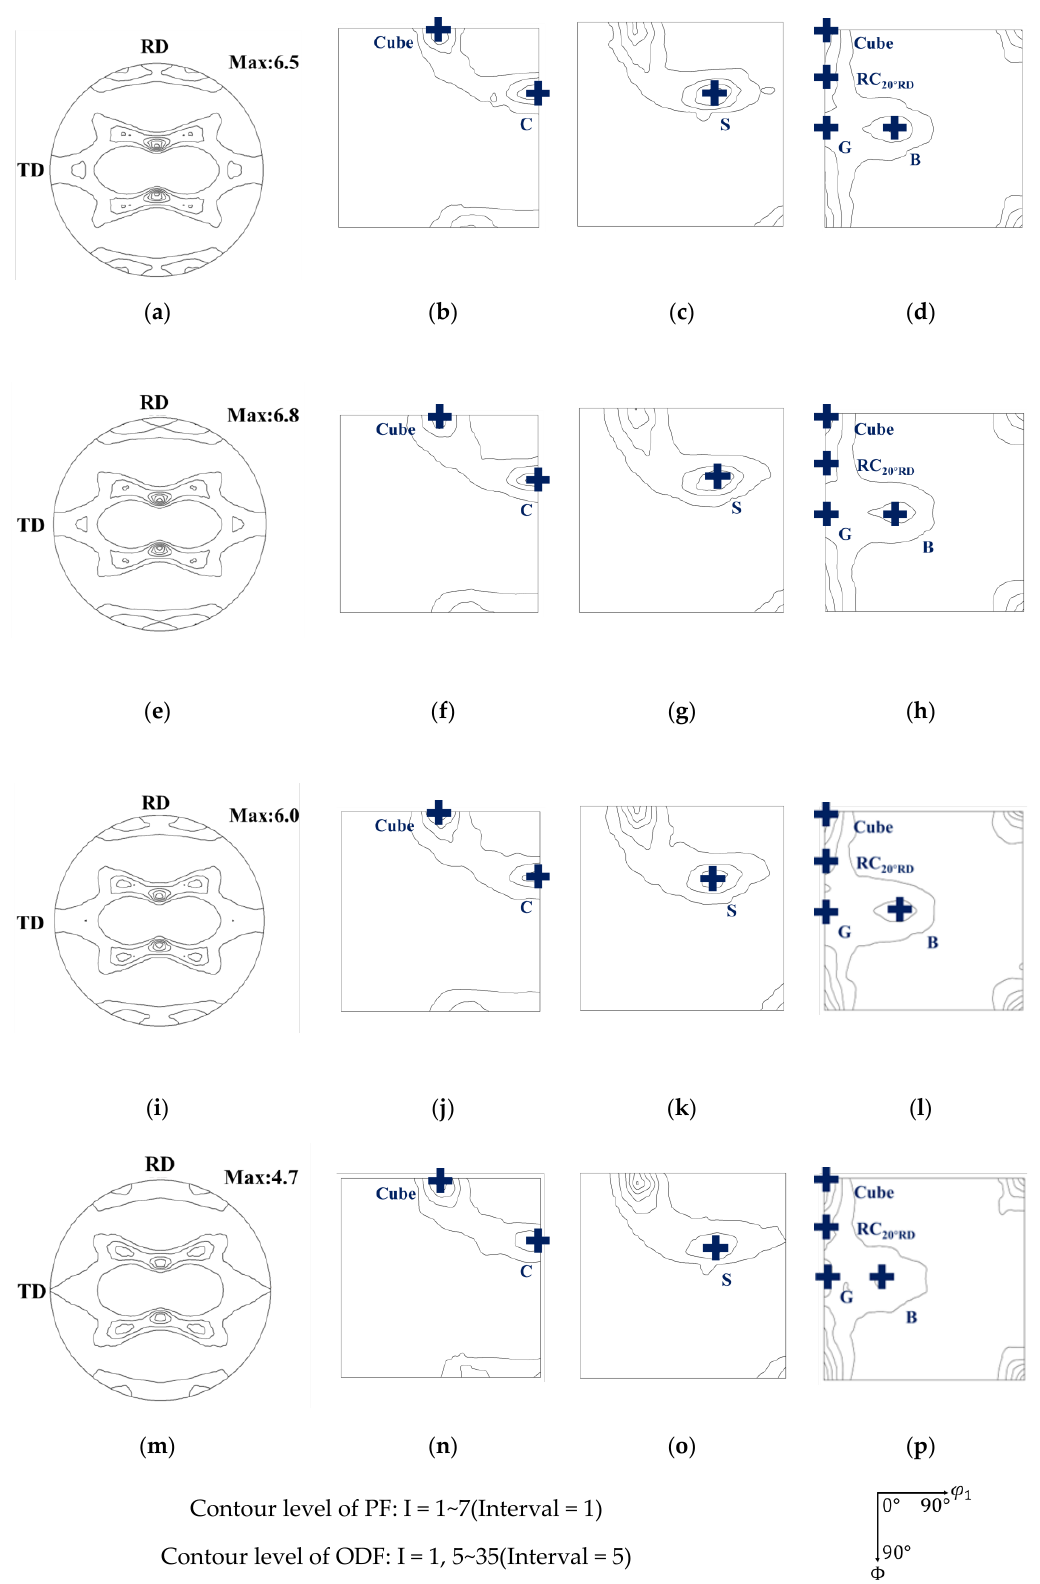
Contour level of PF: I = 1~7(Interval = 1) Contour level of ODF: I = 1, 5~35(Interval = 5) Figure 6. ( a , e , i , m ) {111} Pole figures and ϕ 2 sections of ODF of at 45 ◦ , 65 ◦ , and 90 ◦ in AA5151 alloy